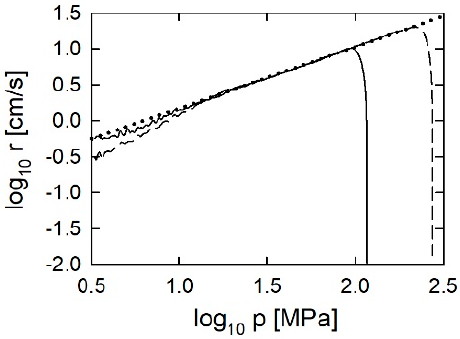
Figure 1. Log_log plots of r ( p ) for LO5460; ∆ = 100 kg/m 3 (solid line), 200 kg/m 3 (dashed line).